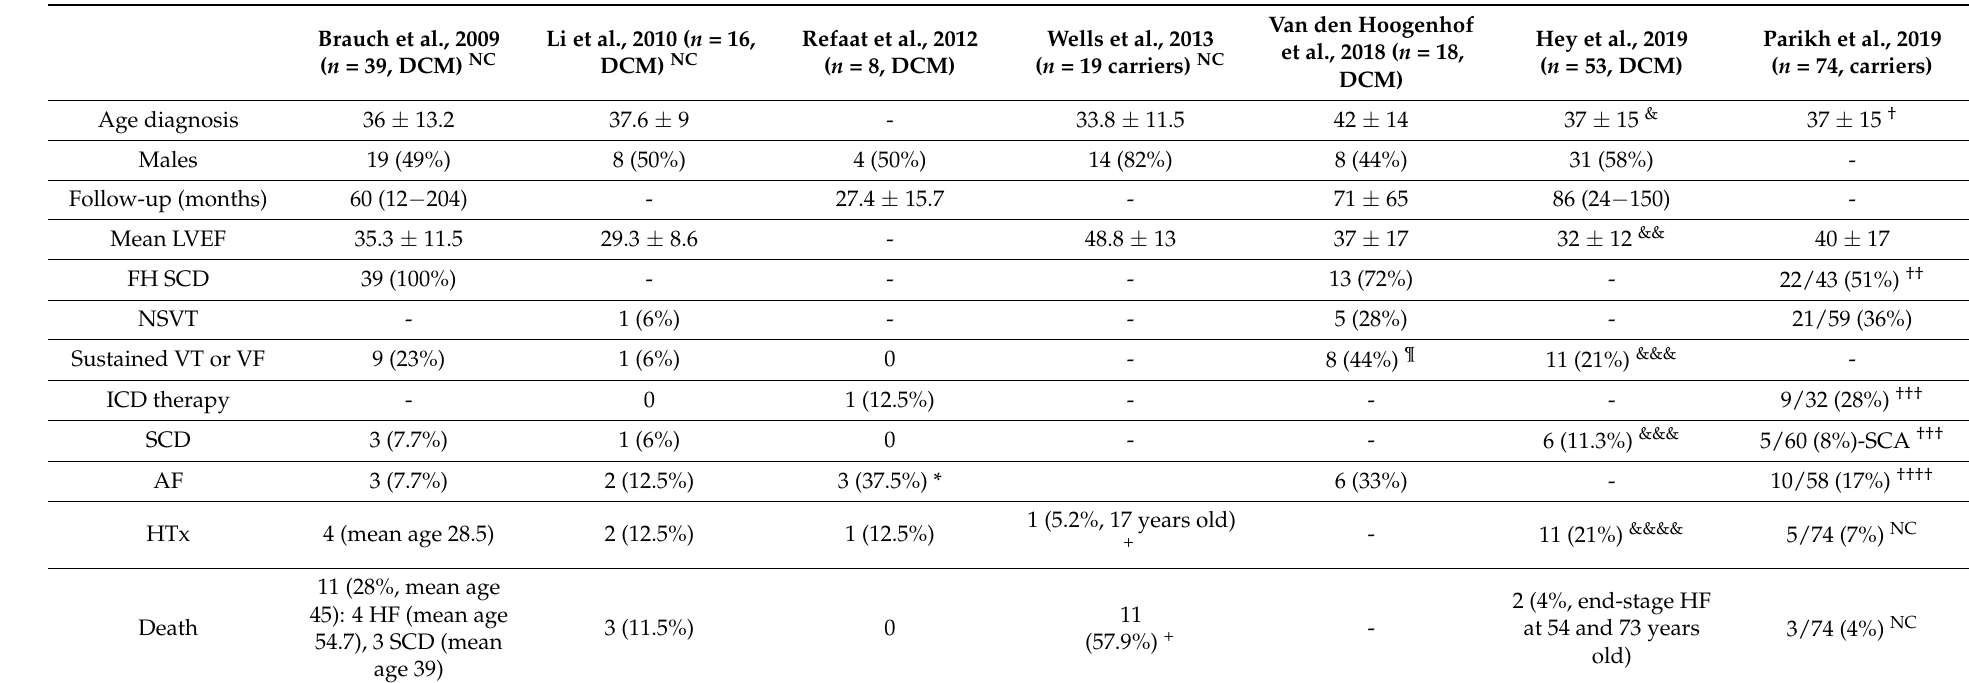
Table 2. Rare variants in RBM20